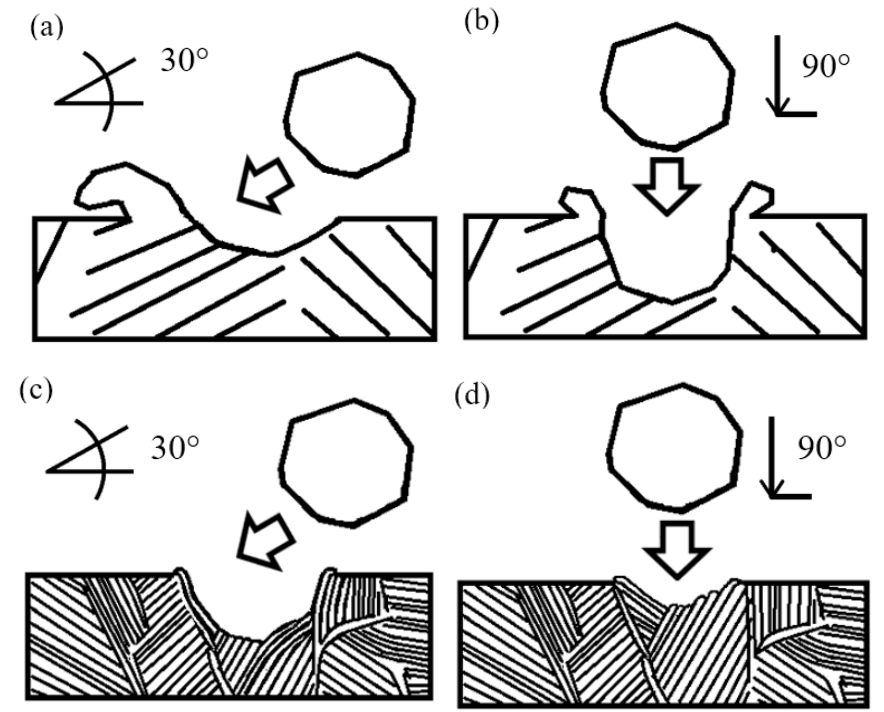
Figure 14. Particle erosion mechanism of AS at ( a ) 30° and ( b ) 90°. Particle erosion mechanism of 800-AC at ( c ) 30° and ( d ) 90°.